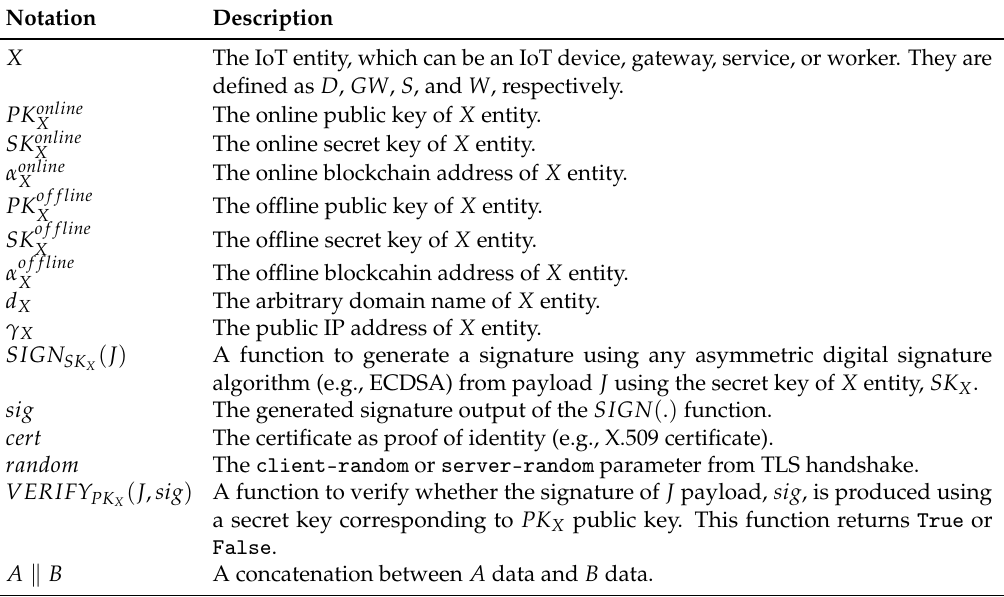
Table 3. The list of new notations introduced in our data in transit design.